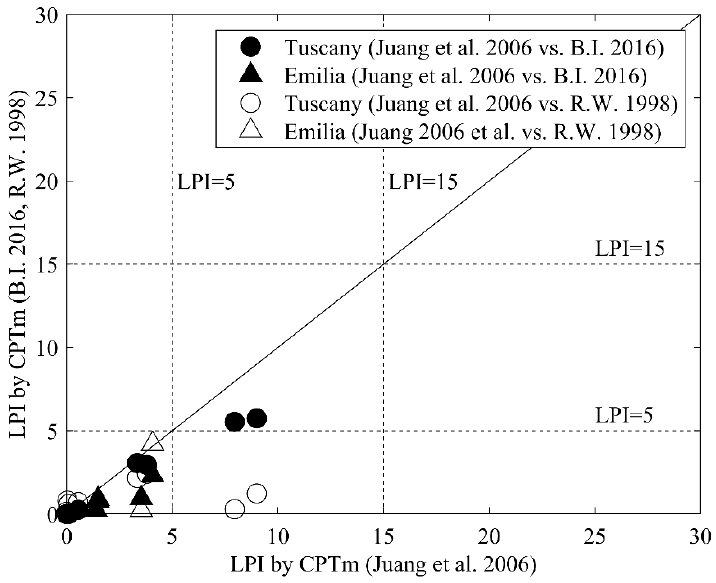
Figure 9. Comparison between the values of the Liquefaction Potential Index (LPI) obtained with CPTu by using all the considered liquefaction evaluation procedures (LEPs). B.I. = Boulanger and Idriss; R.W. = Robertson and Wride.